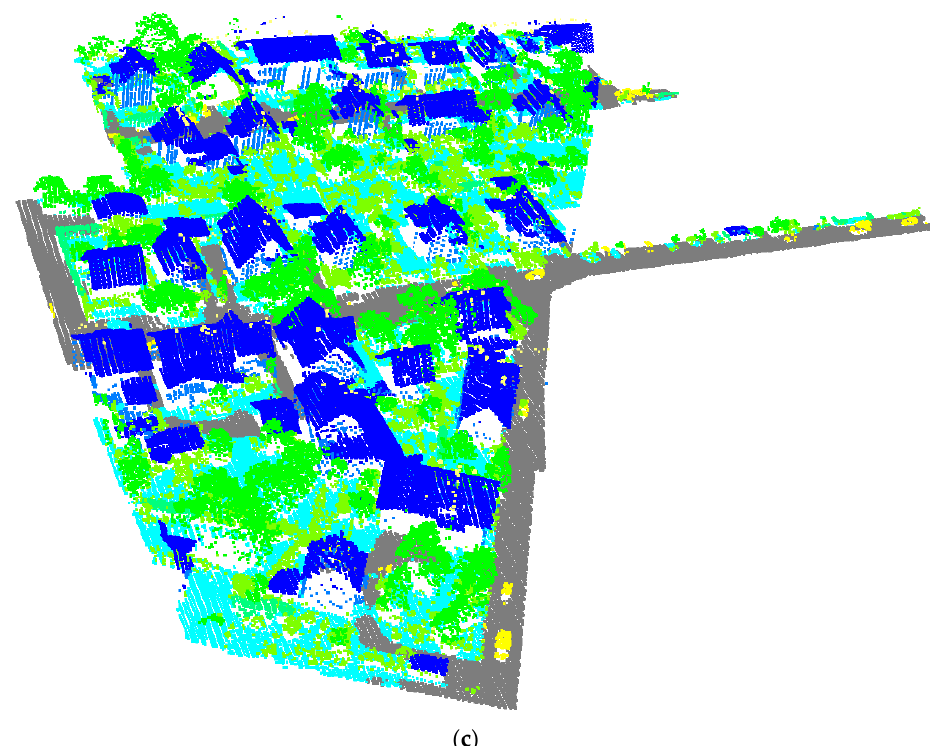
Figure 7. The classification results of our method on the Vaihingen 3D test set. ( a ) Global map of classification results. ( b ) Three-dimensional perspective view of the upper left part. ( c ) Three-dimensional perspective view of the lower right part.